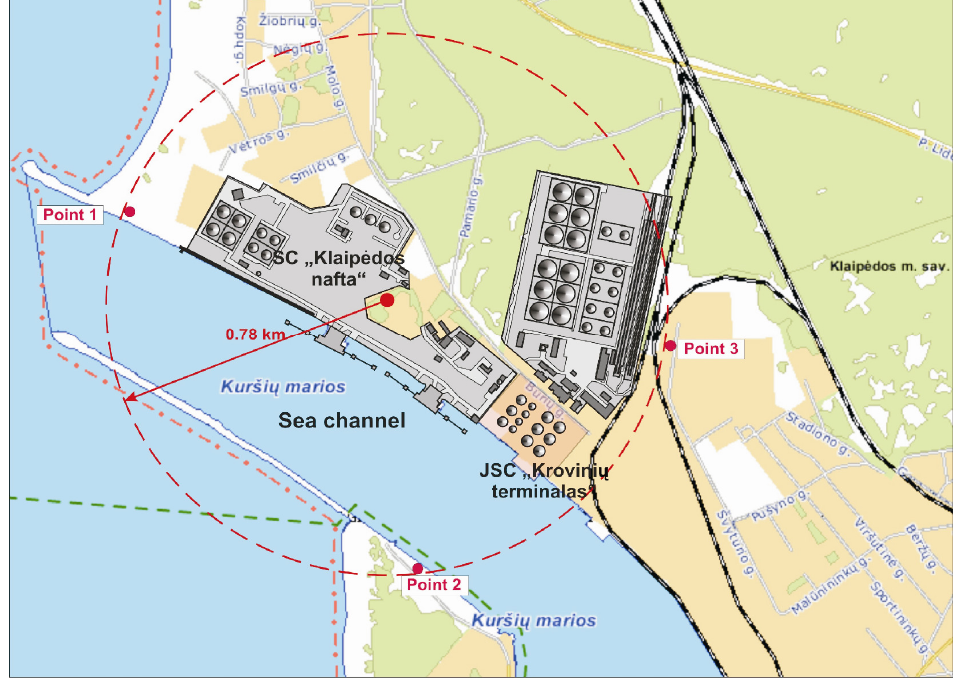
Fig. 1. Location of observation posts around oil terminals (at points